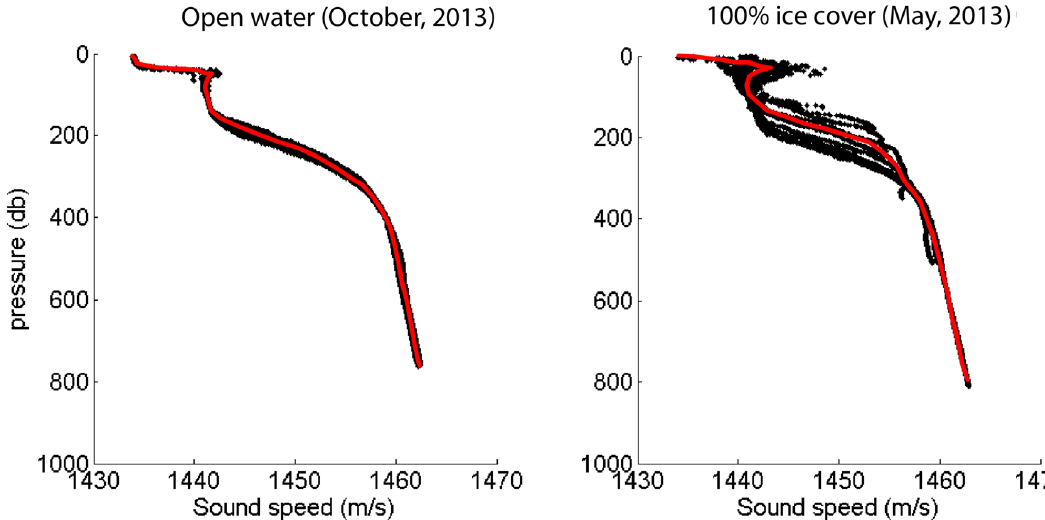
Figure 10. Sound speed profiles during 2013 October (left) and May (right). Black dots are measurements. Curve fit to the data (red line) is used as a representative sound speed profile. Open-water and ice-covered measurements were from the USCGC Healy and an Ice Tethered Profiler (ITP Misfigsion 62; Toole et al. 2011),